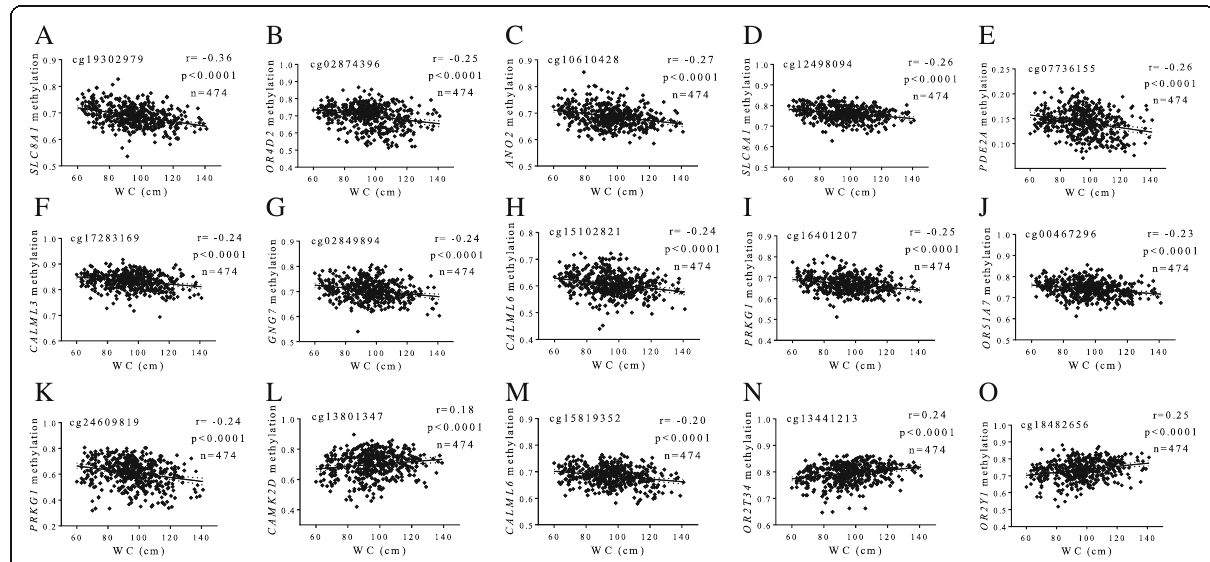
Fig. 2 Associations between methylation levels (beta values) at olfactory pathway genes and WC values. a cg19302979, SLC8A1 ( b ) cg02874396, OR4D2 ( c ) cg10610428, ANO2 ( d ) cg12498094, SLC8A1 ( e ) cg07736155, PDE2A ( f ) cg17283169, CALML3 ( g ) cg02849894, GNG7 ( h ) cg15102821, CALML6 ( i ) cg16401207, PRKG1 ( j ) cg00467296, OR51A7 ( k ) cg24609819, PRKG1 ( l ) cg13801347, CAMK2D ( m ) cg15819352, CALML6 ( n ) cg13441213, and OR2T34 ( o ) cg18482656,